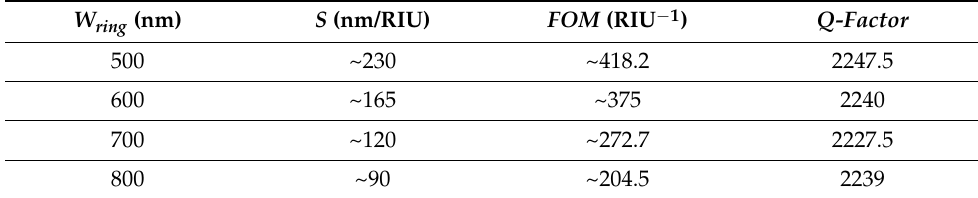
Table 1. RR performance for different values of W ring